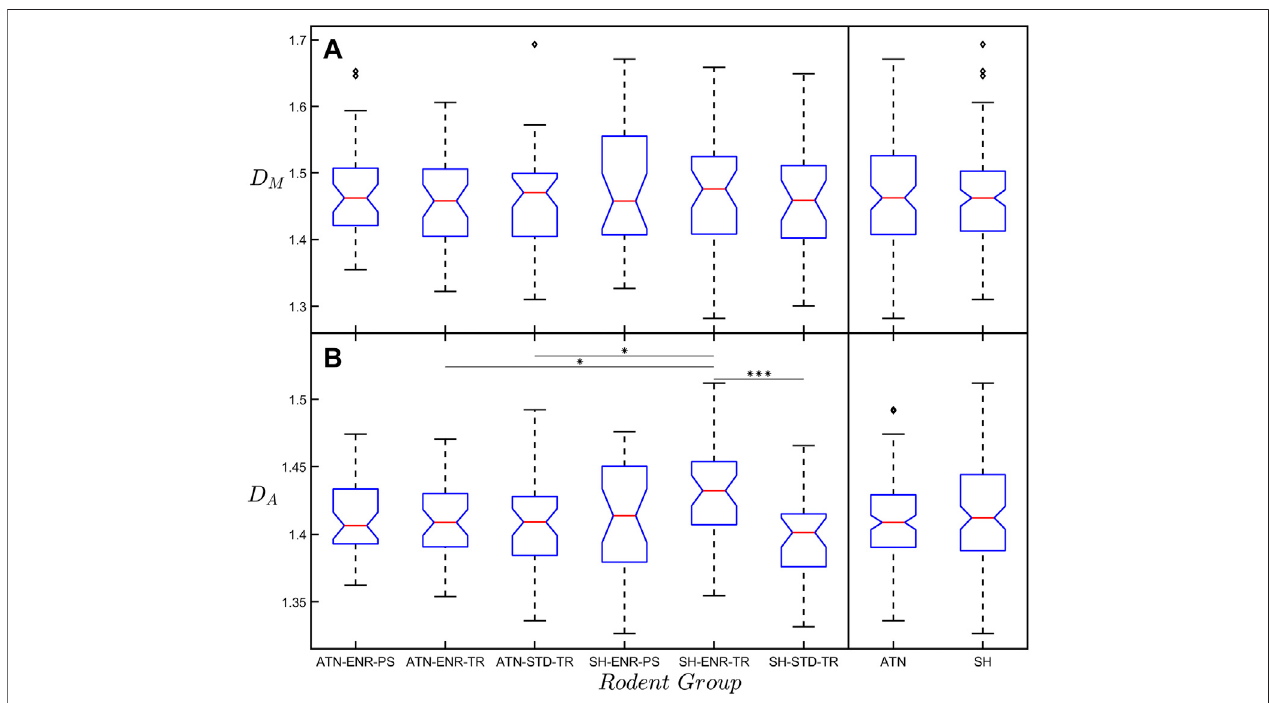
FIGURE 4 | (A) Box plot of the mass fractal dimension, D M , with respect to the six rodent groups. The far-right box plots show the results when collecting the six rodentgroups into theATN and SHcategories. Nosigni fi cant difference in D M exists between any ofthegroups. (B) The same as (A) but for the arborfractaldimension, D A . Anysigni fi cantdifference between the SH-ENR-TR group and the other fi ve groups isindicated by the horizontal lines connecting the groups. The diamond-shaped markers seen in some of the groups indicate outliers within that group. The signi fi cance markers * and *** correspond to p ≤ 0.05 and p ≤ 0.001, respectively.